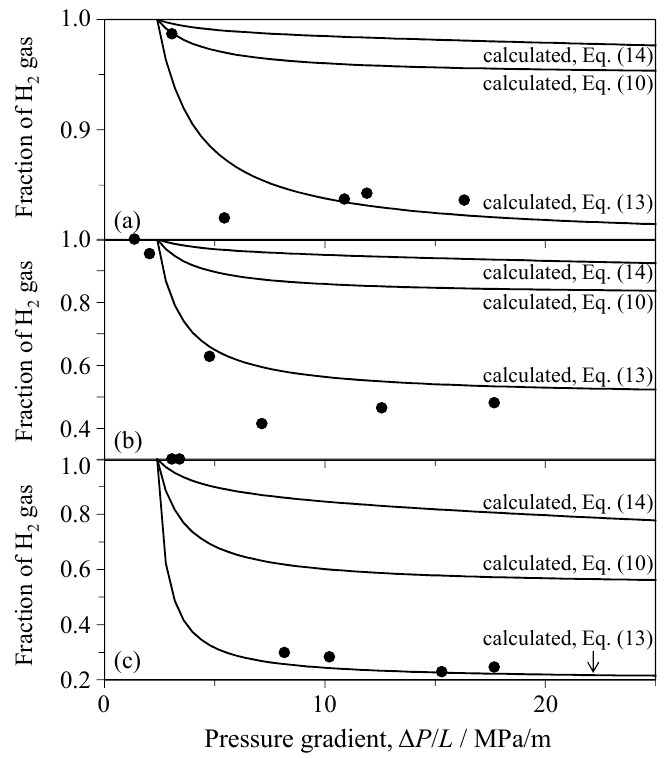
Figure 18. Comparison between measured and calculated H 2 fractions in the porous SiC ceramics hot-pressed at 1400 ◦ C for the supplied gas of ( a ) 80 vol % H 2 –20 vol % CO 2 ; ( b ) 50 vol % H 2 –50 vol % CO 2 ; and ( c ) 20 vol % H 2 –80 vol % CO 2 .